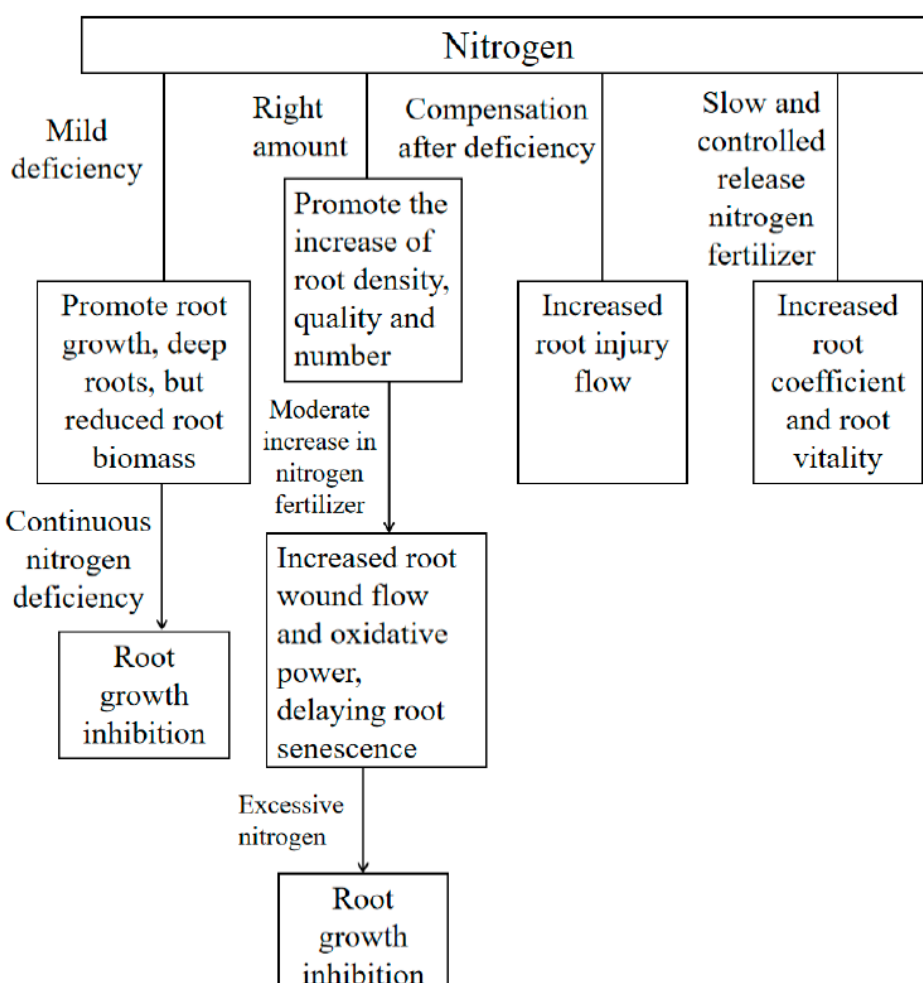
Figure 3. Regulation of nitrogen on changes of root